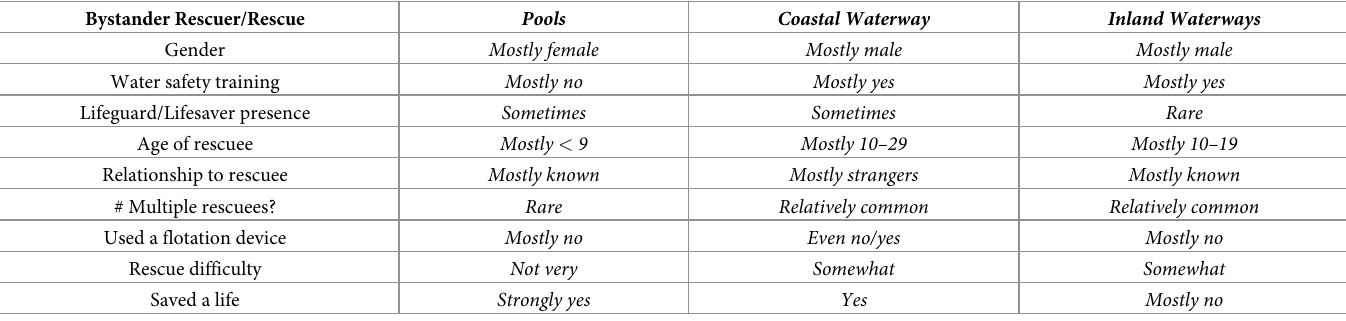
Table 6. Characteristics and differences of bystander rescuers and rescues between Australian aquatic